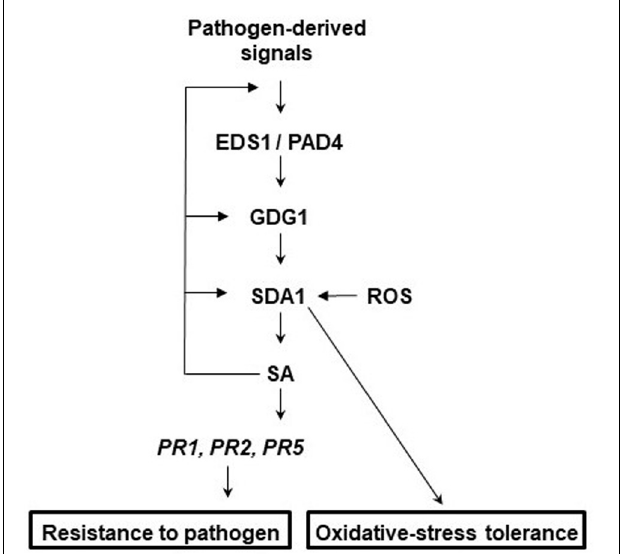
FIGURE 9 | Proposed model for the role of SDA1 in defense signaling and oxidative-stress tolerance. In response to virulent pathogens, expression of SDA1 is regulated via EDS1, PAD4, and GDG1 (also known as PBS3 and WIN3) but not SID2. SDA1 is at least in part required for pathogen-induced SA biosynthesis, which in turn regulates expression of PR genes and defense via NPR1. SA regulates expression of SDA1 by positive feedback controls, possibly via GDG1. Additionally, control via GDG1 may be dependent on positive feedback to GDG1 at low SA levels and negative feedback at high SA levels. In addition, SDA1 modulates tolerance to oxidative